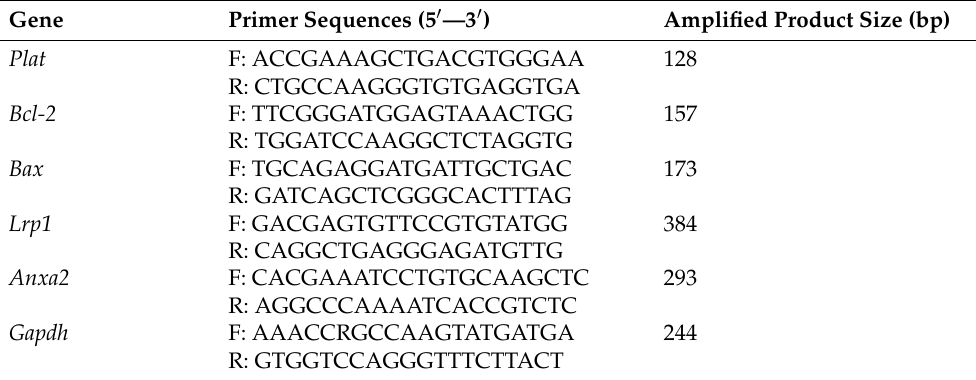
Table 1. Oligonucleotide primer sequences used for real-time PCR in this study. Gene Primer Sequences (5 (cid:48) —3 (cid:48)